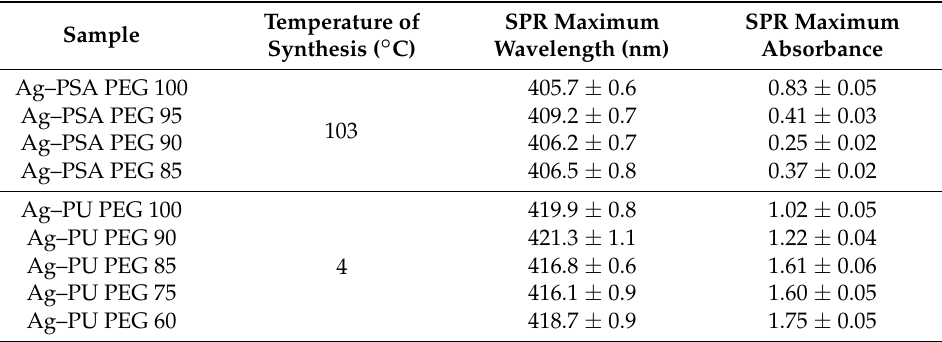
Table 2. Characteristics of the surface plasmon resonance (SPR) band for Ag–PSA and Ag–PU hydrogel